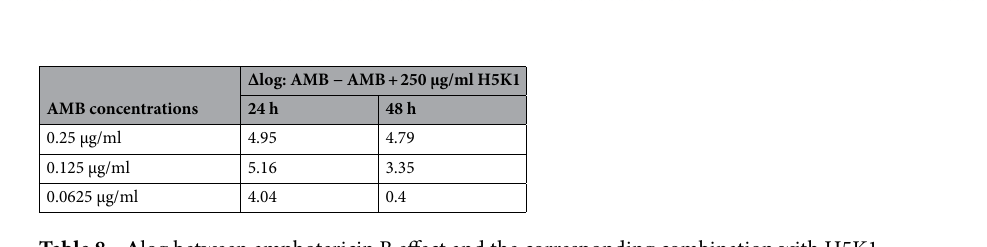
Table 8. ∆ log between amphotericin B effect and the corresponding combination with